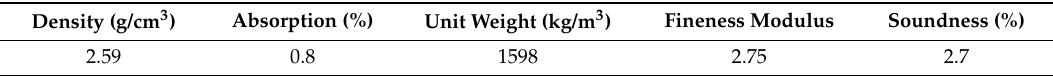
Table 3. Physical properties of fine aggregate.